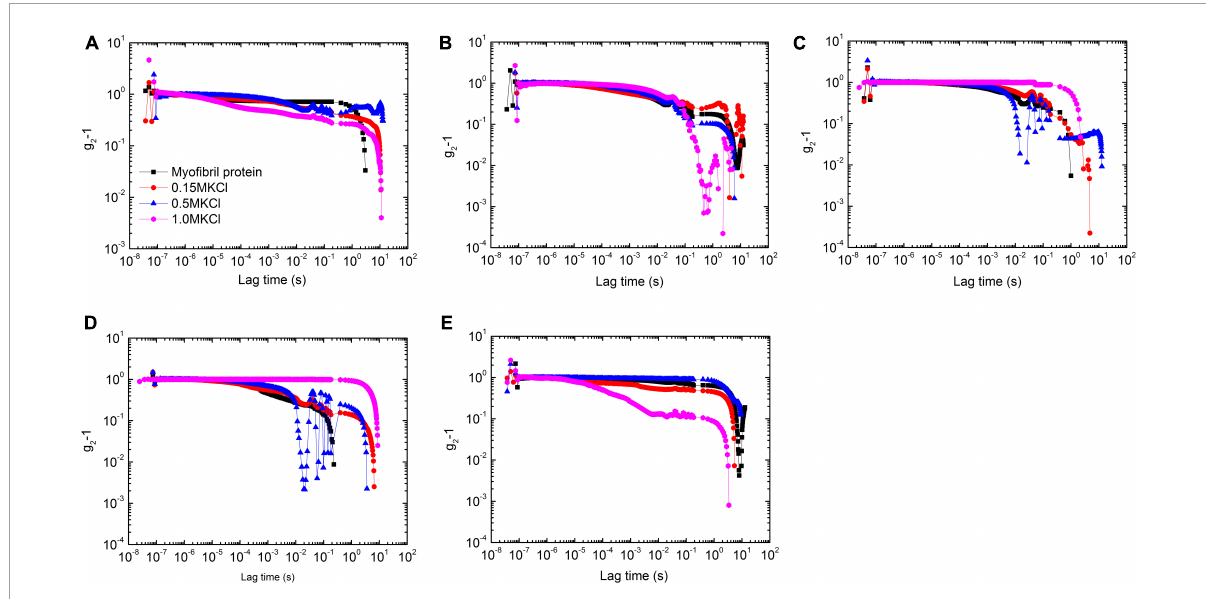
FIGURE3 The correlation functions of myofibrillar protein solutions under 5 temperatures [25 ◦ C (A) , 30 ◦ C (B) , 35 ◦ C (C) , 40 ◦ C (D) , and 45 ◦ C (E) ] with 4 concentrations of KCl [0 mol/L (black square), 0.15 mol/L (red circle), 0.5 mol/L (blue triangle), and 1 mol/L (magenta diamond)].